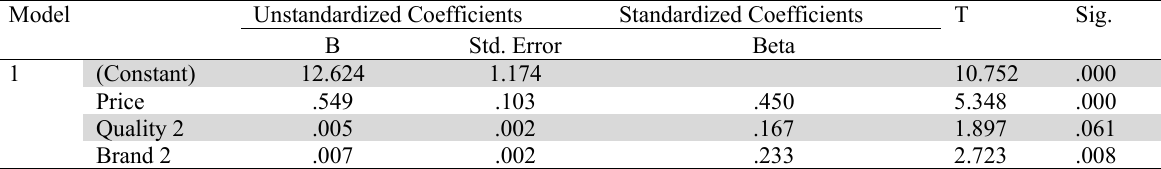
Model 10 Multiple Linear Regression Test Results (Coefficients a )